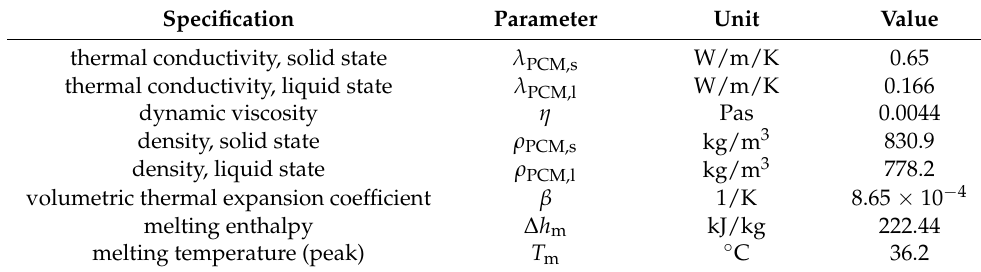
Table 2. Material properties of